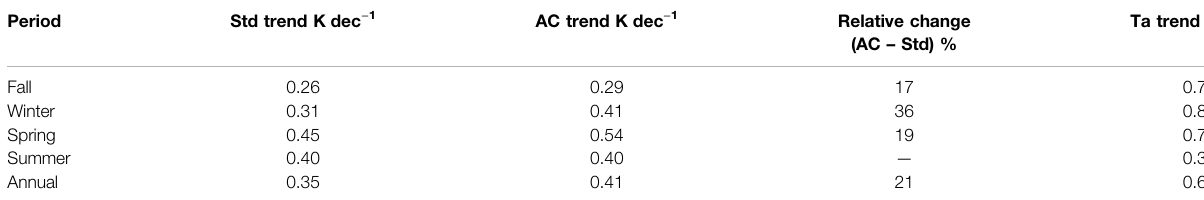
TABLE 6 | Trends of near-surface soil temperature (Tss), derived from the standard (Std) and Arctic (AC) simulations and of near-surface air temperature (Ta) from ERA- Interim outputs between 1979 and 2018 over the Arctic area. Winter is de fi ned as November to March, spring as April and May, fall as September and October and summer as June to August.